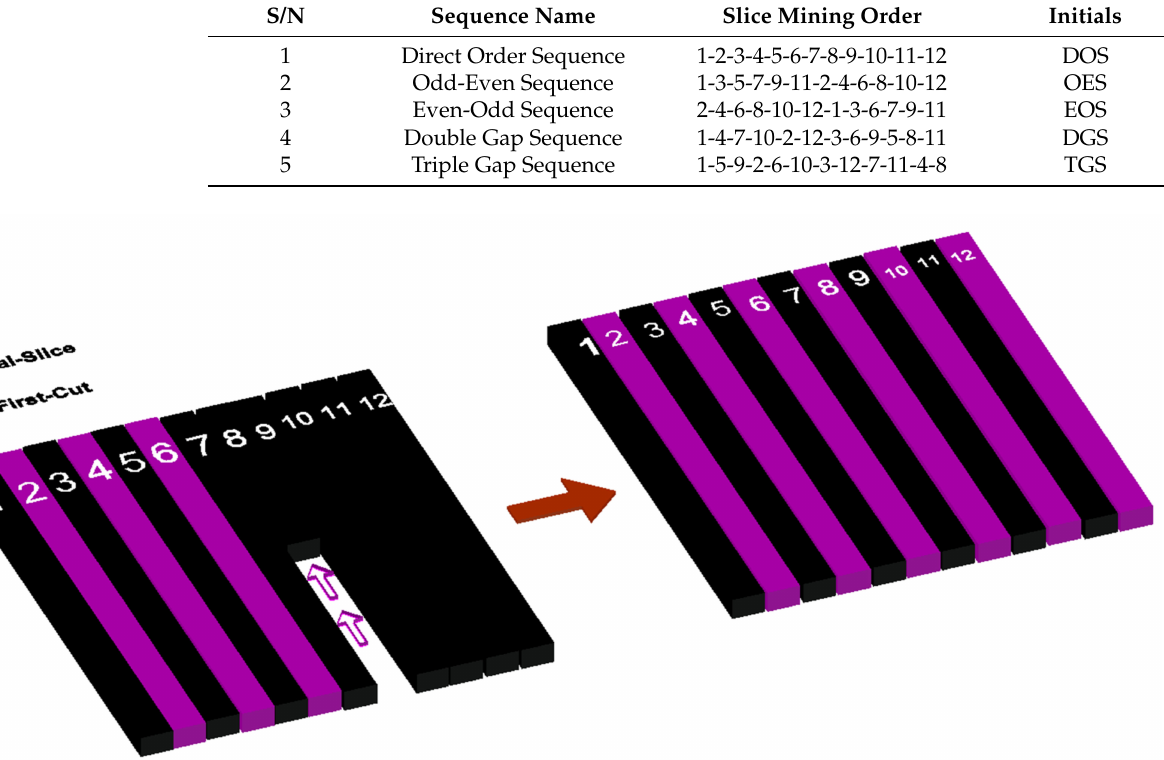
Figure 7. Even-odd slice mining